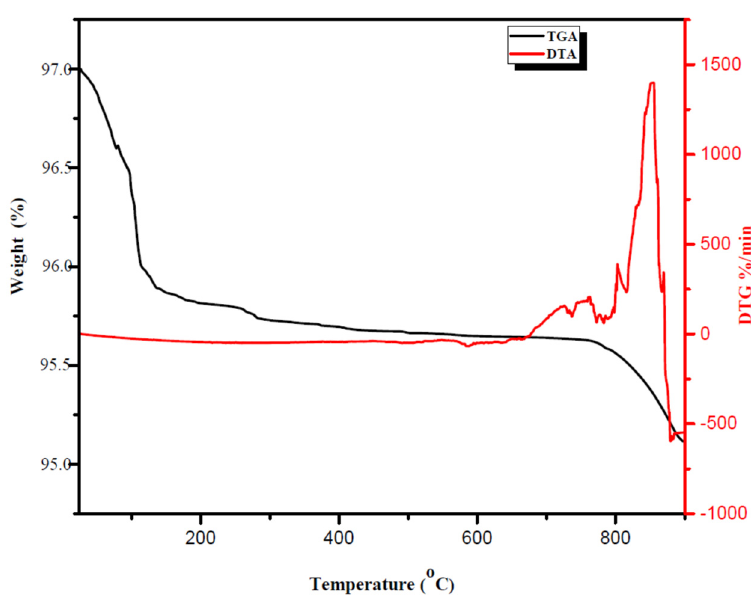
Figure 7. TGA-DTA curves of SNP s .